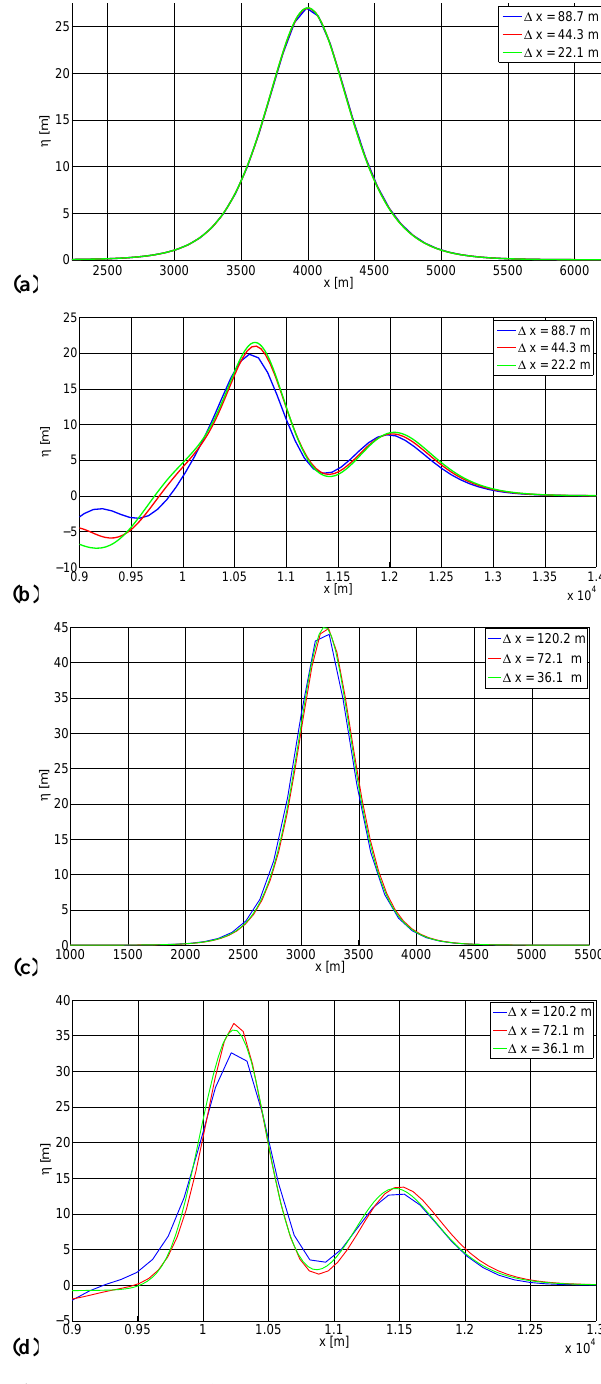
Fig. 10. Transects of the simulated solitary wave propagation in a trapezoidal channel. (a) Initial condition and A/d = 0 . 18, (b) A/d = 0 . 18 and t = 201 s . (c) Initial condition and A/d = 0 . 3, (d) A/d = 0 . 3 and t = 200 s